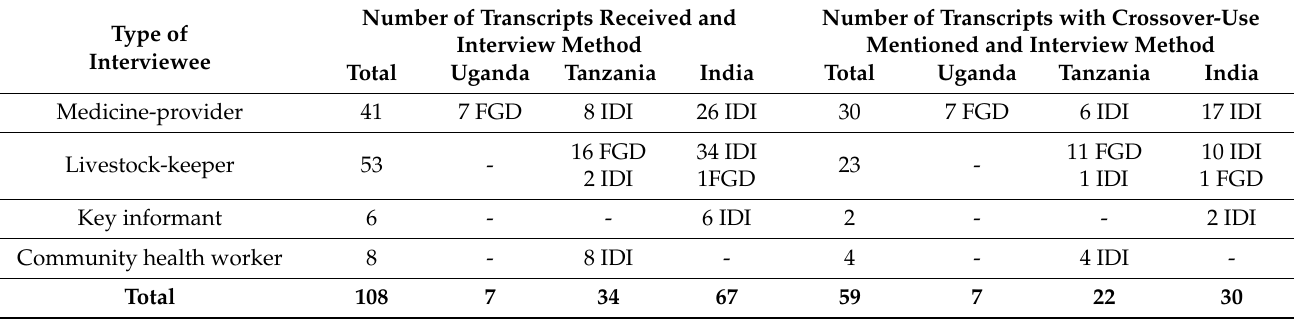
Table 6. Number of transcripts included in this analysis per country, by interview method and interviewee